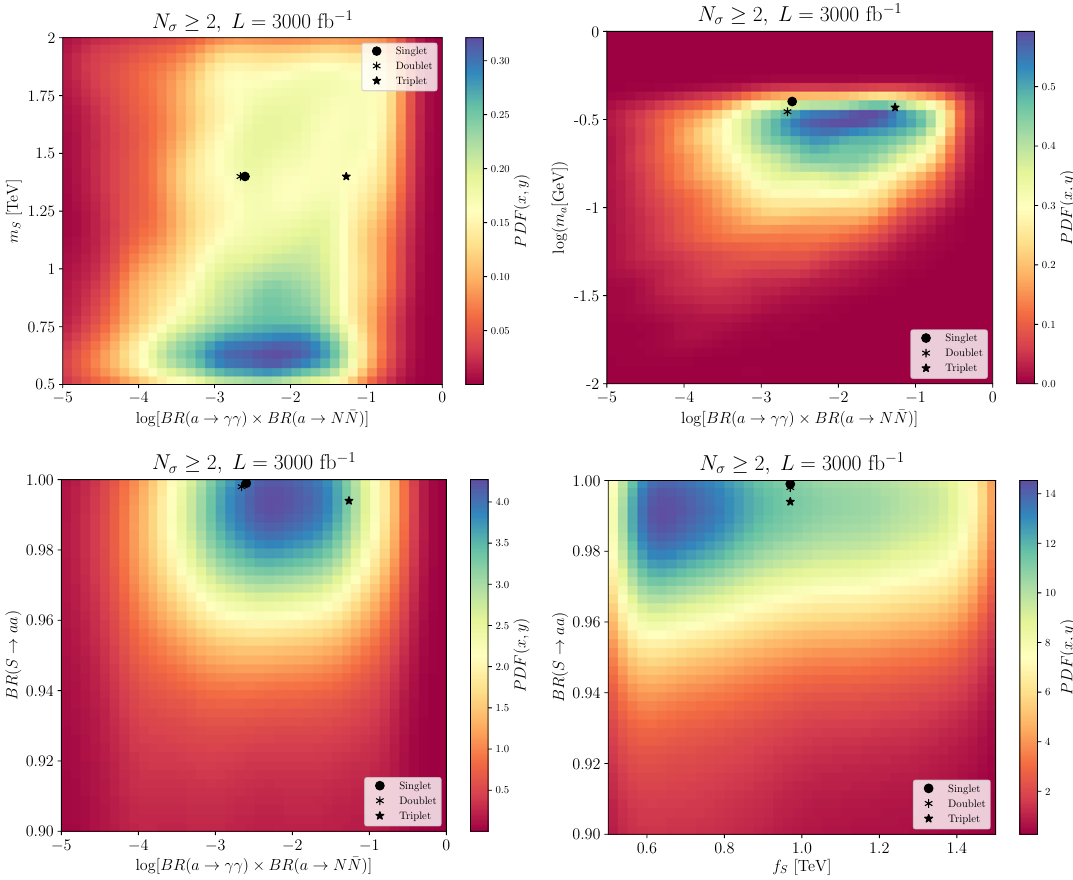
Figure 8 . Heat maps in the plane BR ( a ! (cid:13)(cid:13) ) (cid:2) BR ( a ! N (cid:22) N ) versus m S and m a are shown at the upper left and upper right panels, respectively. In the lower panels we display BR ( S ! aa ) versus BR ( a ! (cid:13)(cid:13) ) (cid:2) BR ( a ! N (cid:22) N ) and f S at the left and right, respectively. In all cases we show the regions that can be probed at 2 (cid:27) and L = 3000 fb (cid:0) 1 . The dot, asterisk and star represent examples of a singlet, doublet and triplet representation of the UV complete model presented in section 5,